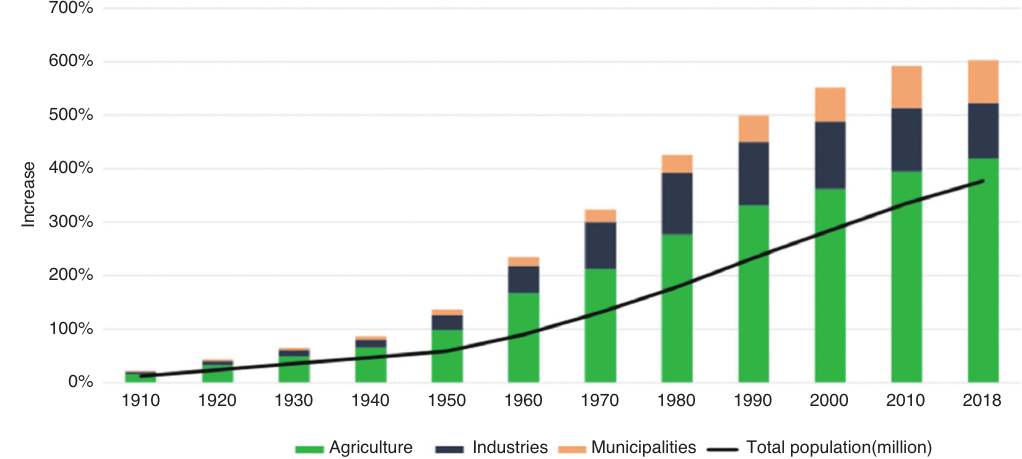
Percentage increase (respect to year 1900) of total population and water withdrawal (km 3 by sector) in the last century. Global water withdrawal and world population from 1900 to 2018. Source: Shiklomanov 2000 [22] for water withdrawal 1990–2000; AQUASTAT for 2010 and 2018. Population data from FAOSTAT [23].